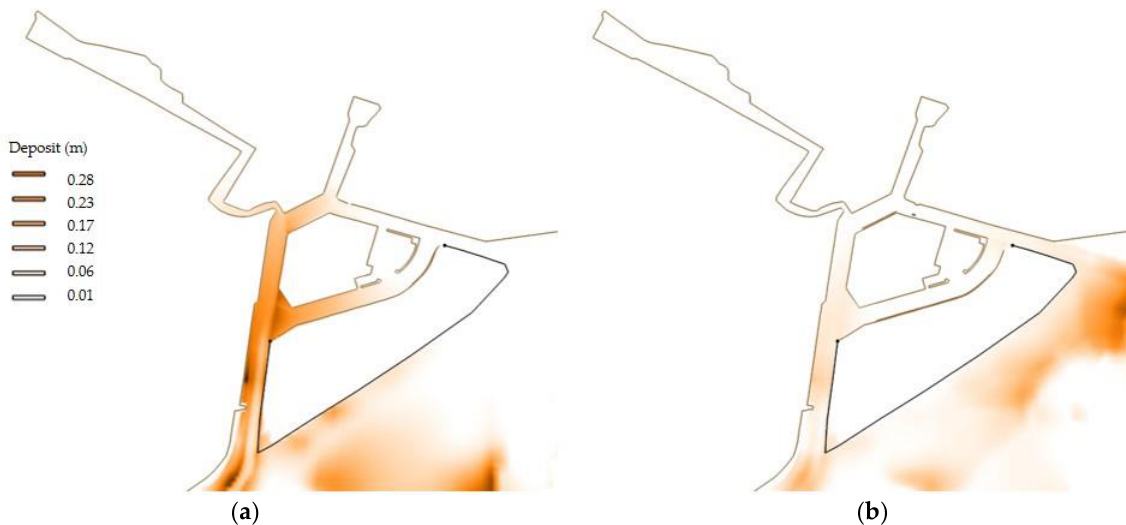
Figure 12. Sediment deposition at the end of the simulated average year: ( a ) Bora contribution; ( b ) Sirocco contribution.